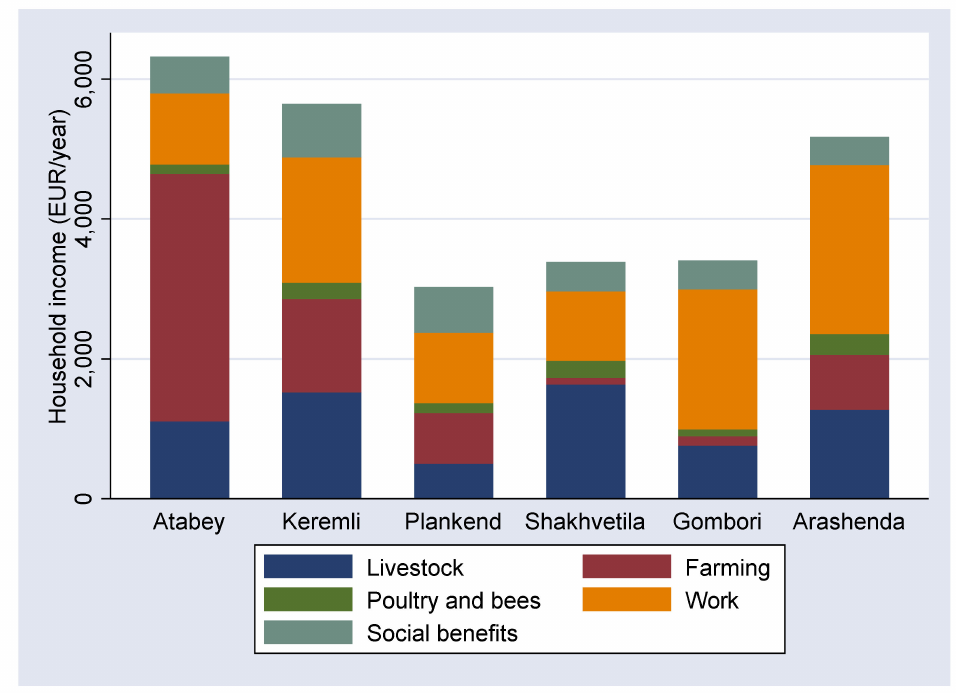
Figure 3. Household income and its composition in the case study villages (N =